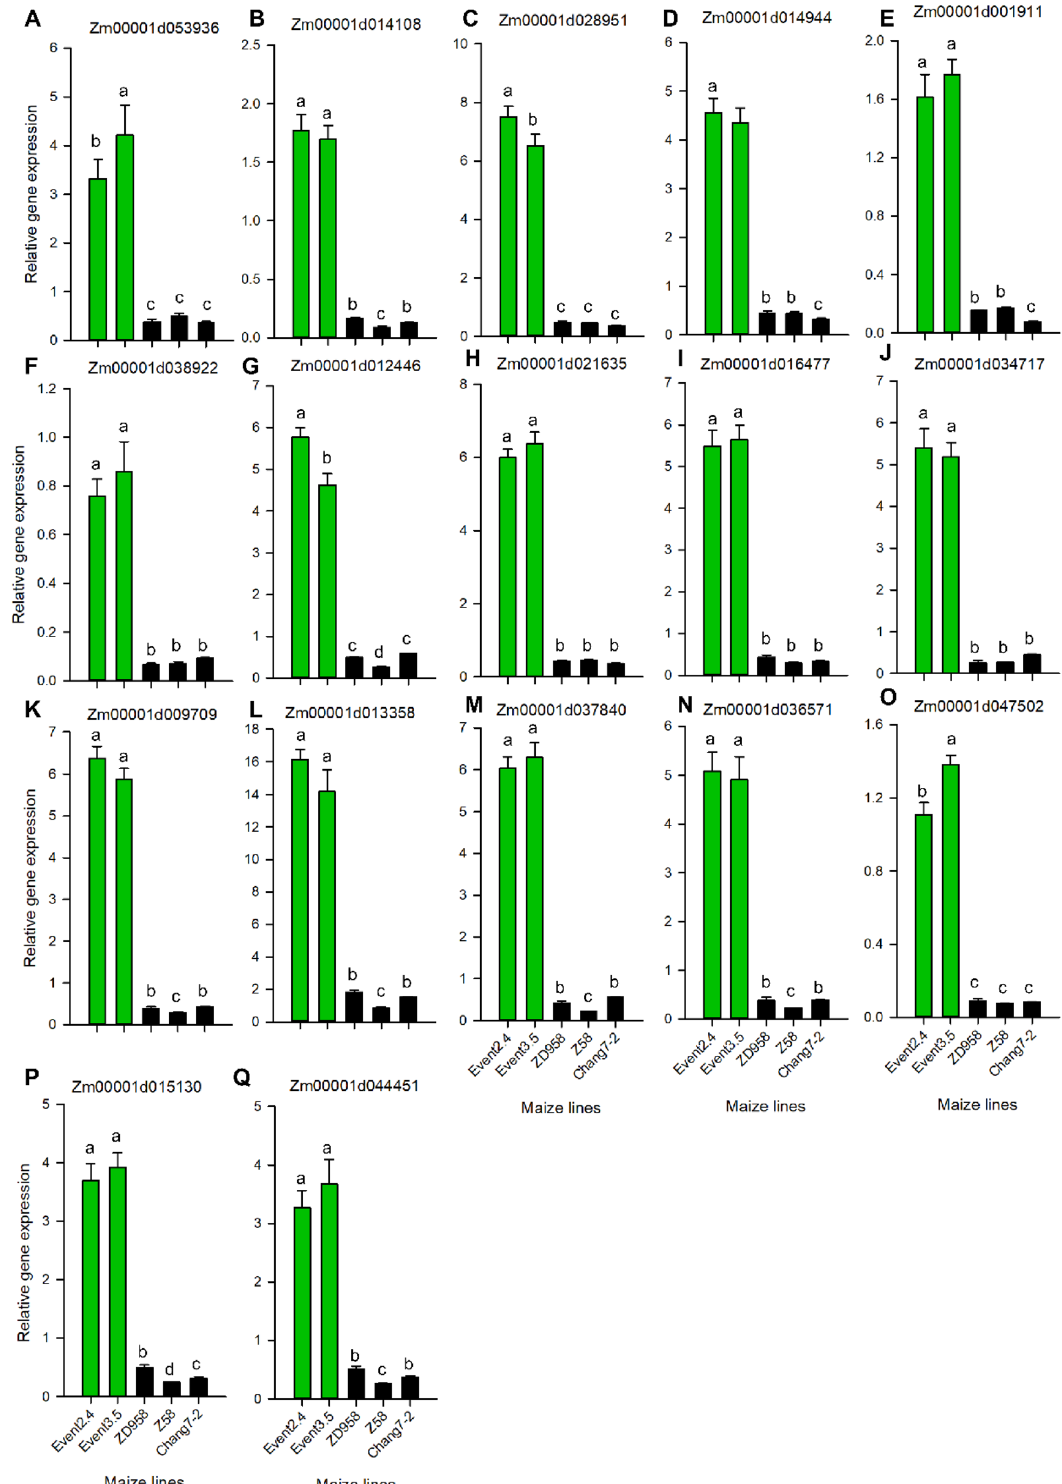
Figure 4. qPCR testing the relative gene expression with top 5% differential expressed genes between two transgenic event (3.5 and 2.4) and other genetic background (Chang7-2, Z58) and non-GM counterpart (ZD958) ( A – Q ). Different alphabet letters represent significant differences at P < 0.05 based on one-way ANOVA . n =